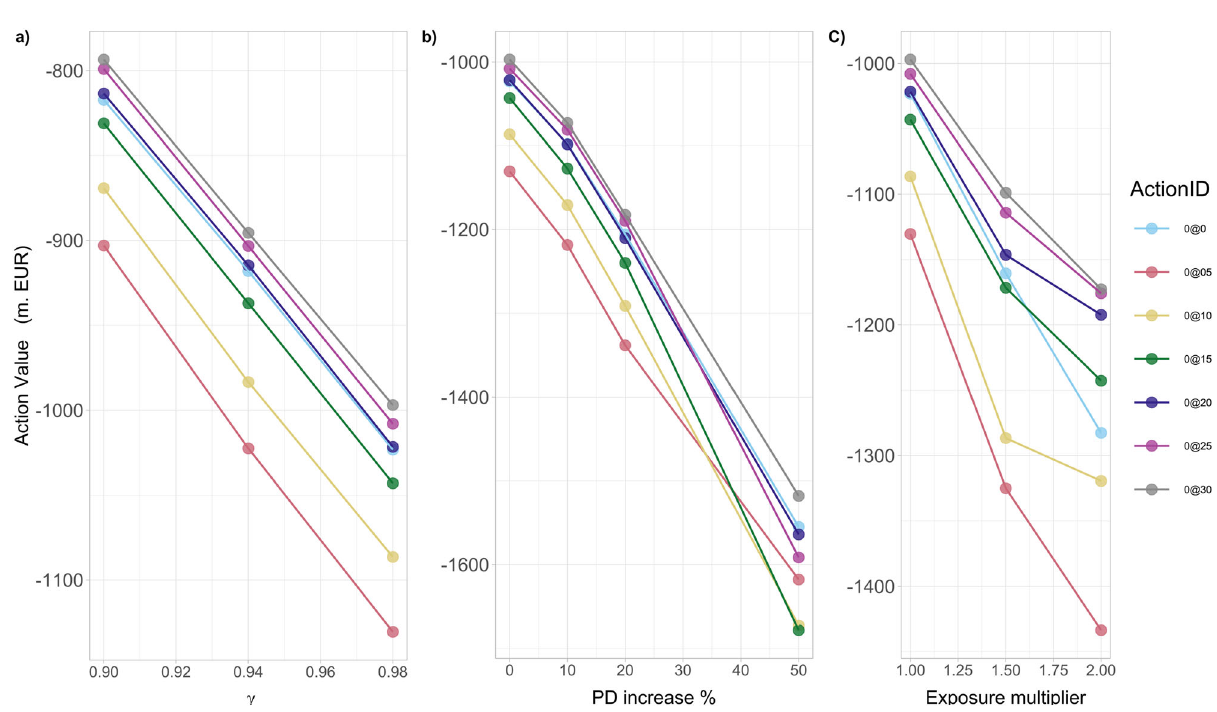
Fig. 7 | The optimalactionvalue Q * ( s 0 , a 0 ) for the EuropeanBanking Authority (EBA) network at time 0. In the legend, ActionID 0@0 means no investment, 0@05 means investing 0.5 in all the nodes, etc. The results are obtained for the percentage α =0.005ofwealthlossupondefault. a Asafunctionofdiscountfactor s a γ , Q * ( 0 , 0 ) decreases,for all potential actions